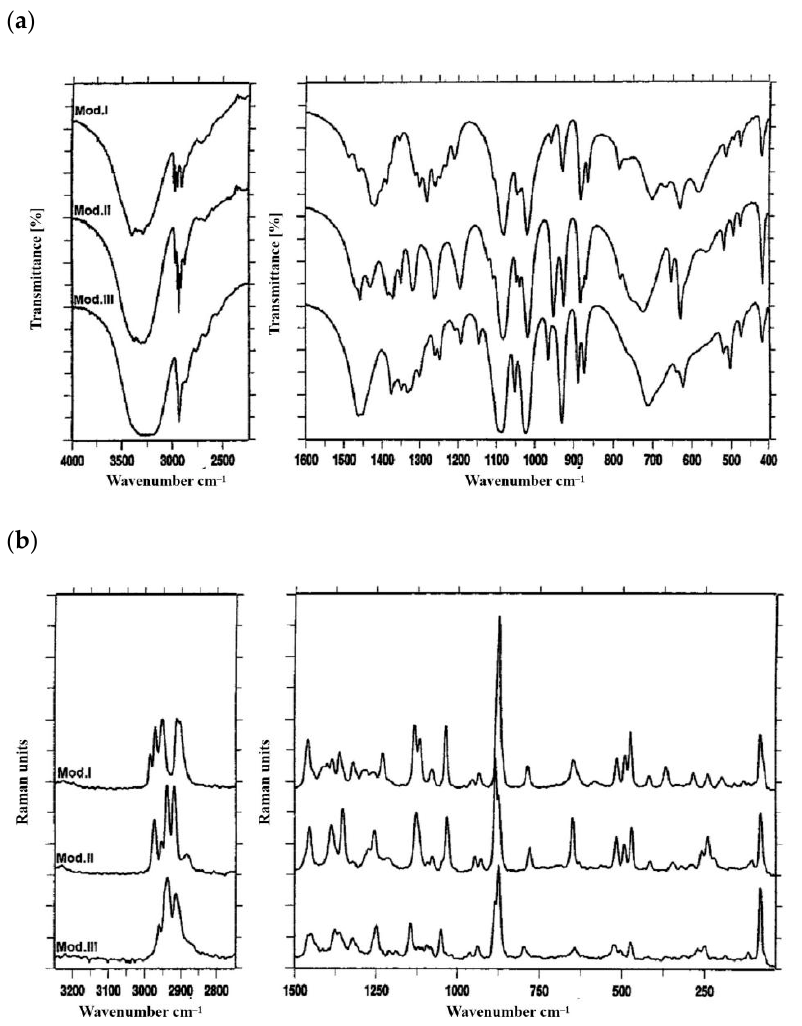
Figure 7. The FTIR and Raman spectroscopy of D -mannitol polymorphs. ( a ) FTIR and ( b ) Raman spectroscopy. Reprinted from Ref. [42] Copyright 2000, with permission from Elsevier.